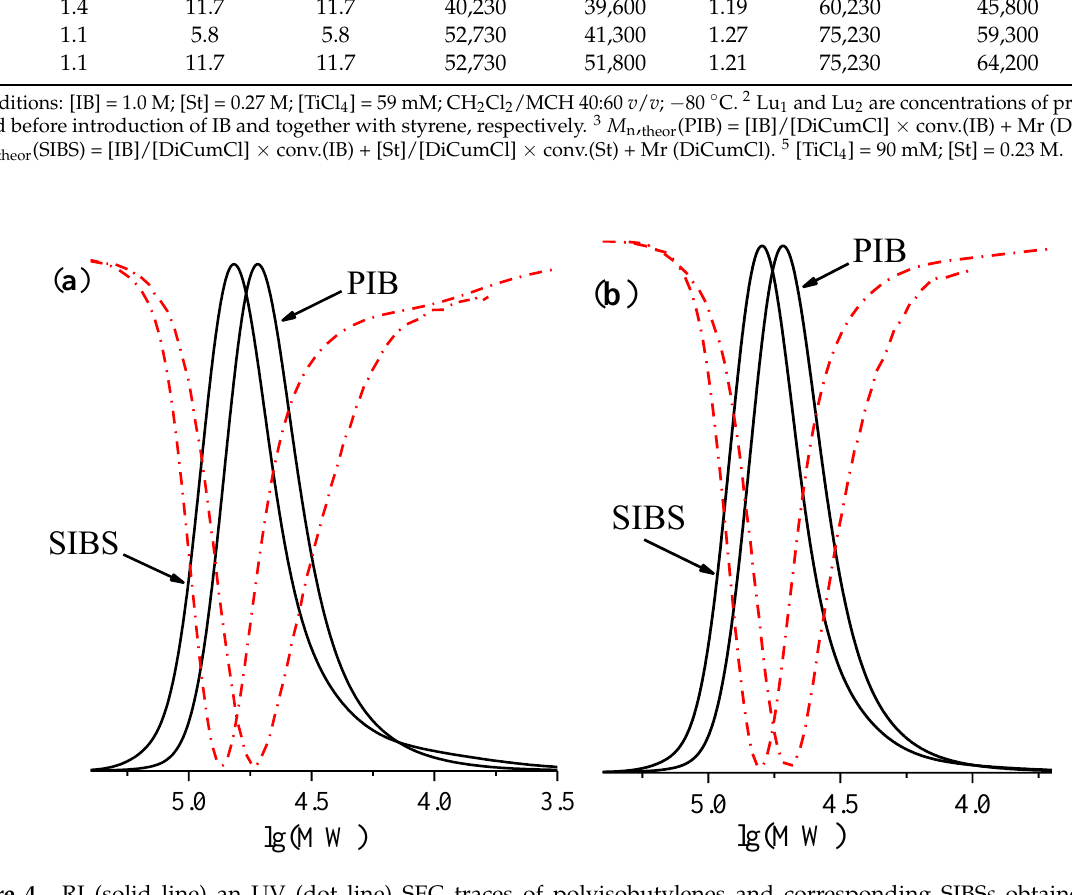
Figure 4. RI (solid line) an UV (dot line) SEC traces of polyisobutylenes and corresponding SIBS s obtained with DiCumCl/TiCl 4 /Lu initiating system in CH 2 Cl 2 /MCH 40:60 v / v at − 80 °C using different modes of proton trap addition. Proton trap addition: ( a ) one-step (run 6, Table 1); ( b ) two-steps (run 7, Table 1).